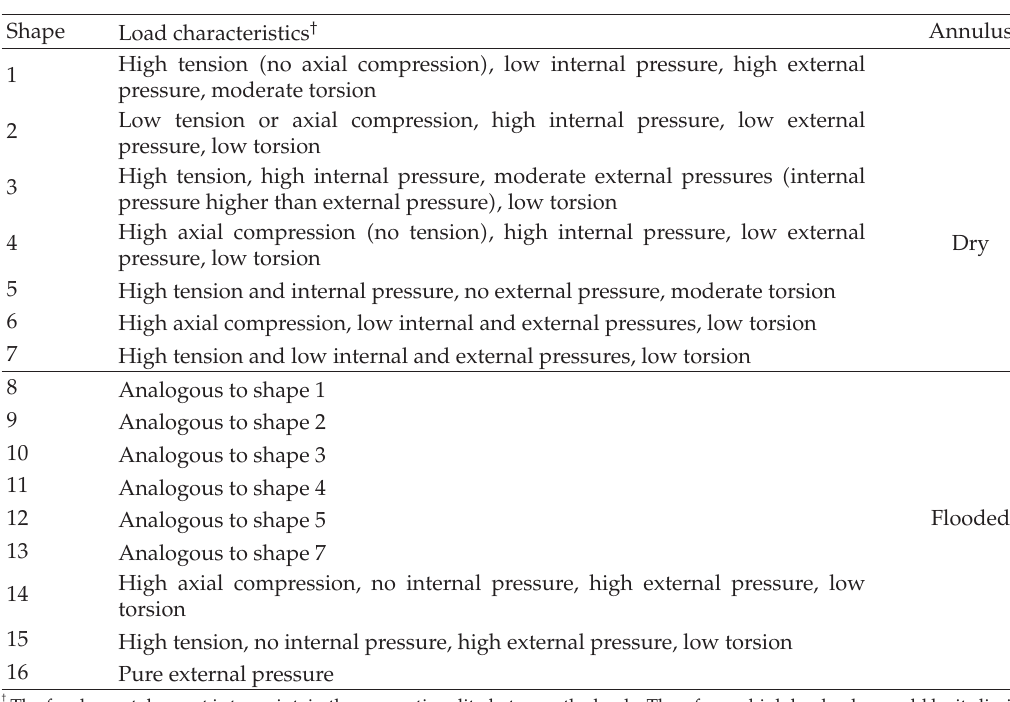
Table 2: Load characteristics for each possible deformed shape of a typical unbonded flexible pipe considering di ff erent annulus conditions and axisymmetric